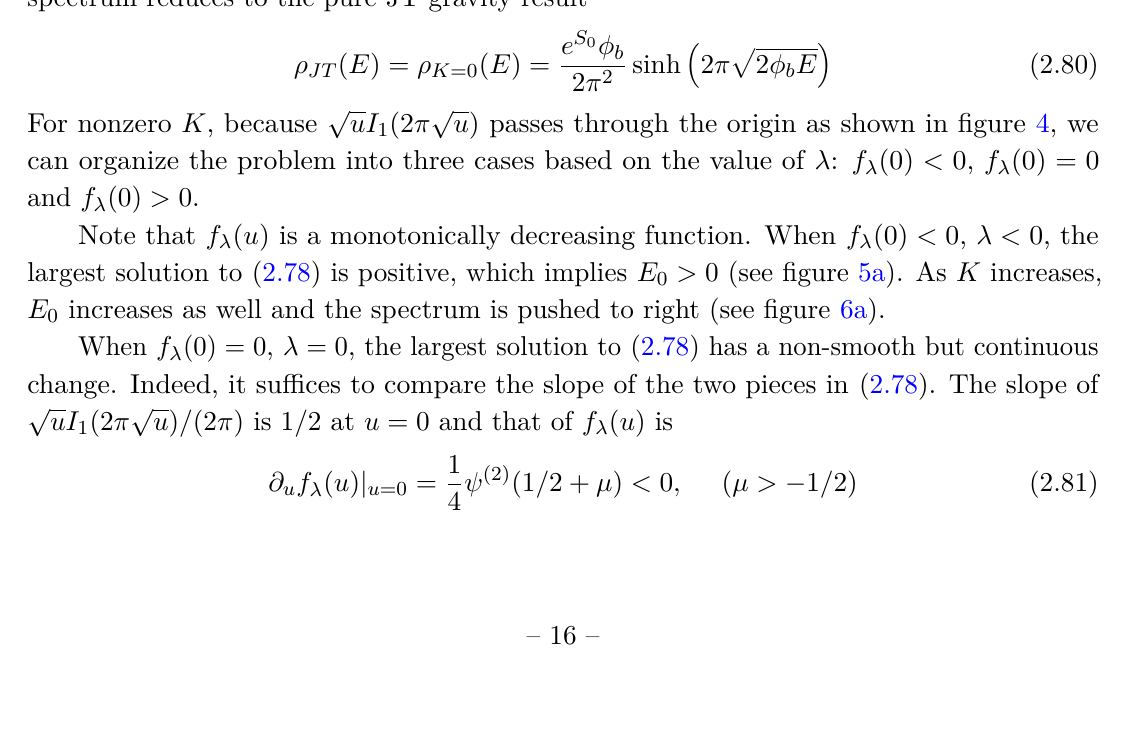
Figure 6. Plot of spectral density ρ ( E ) for different λ . Each color represents taking the K value corresponding to the same color curve in figure 5. All parameters are identical to figure